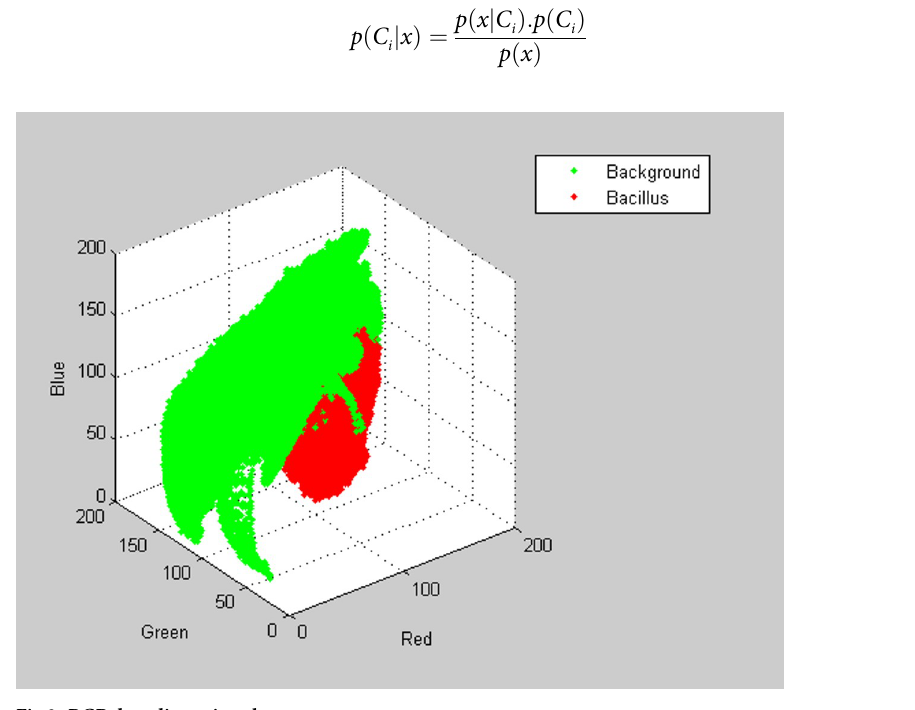
Fig 2. RGB data dispersion